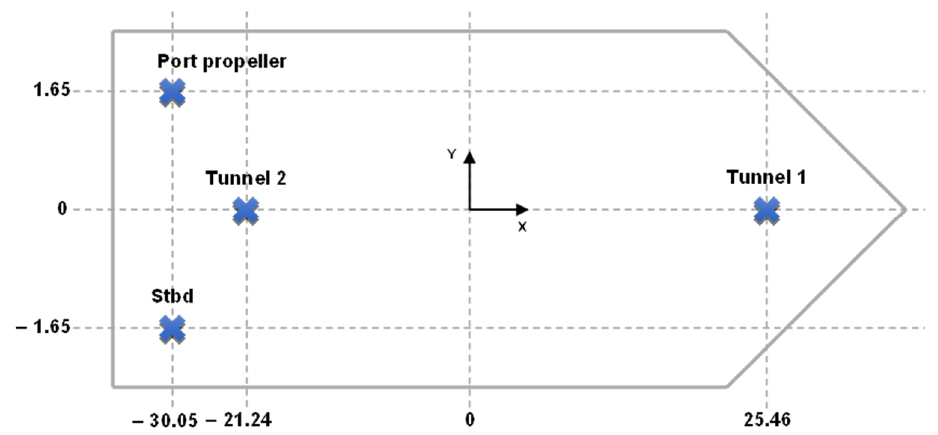
Figure 12. Distribution of thrusters on the ship.